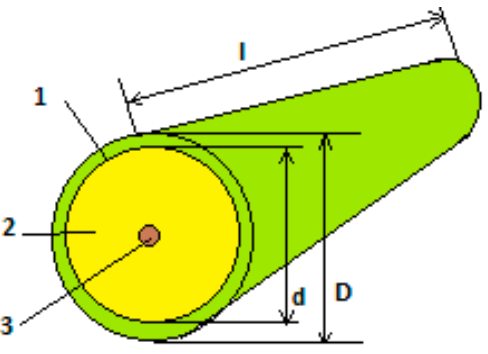
Figure 3. Macroscopic structure of energetic willow shoots: 1—bark; 2—xylem; 3—pith; l—the length of the seedling; d—inner diameter of the wooden part of the twig; D—outer diameter of the willow twig.